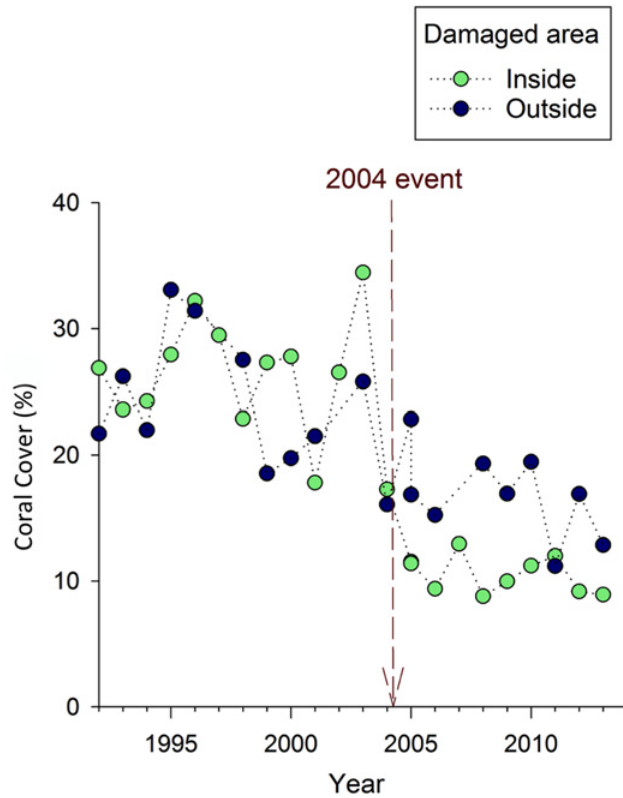
Fig 3. Mean absolute coral cover (%) over time at Crab Cove, showing changes inside and outside the area damaged by the 2004 anchoring event. The dotted vertical line indicates the timing of the 2004 anchoring